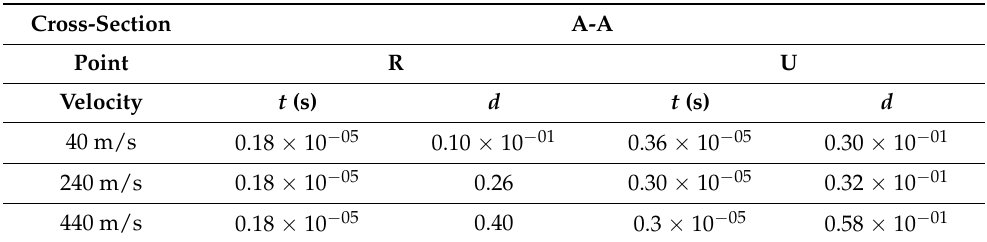
Figure 12. Damage parameter variation, cross-section C-C: ( a ) point P; ( b ) point S. Table 1. Time instance (s) when damage appears at observed points and the damage value, cross- section A-A.